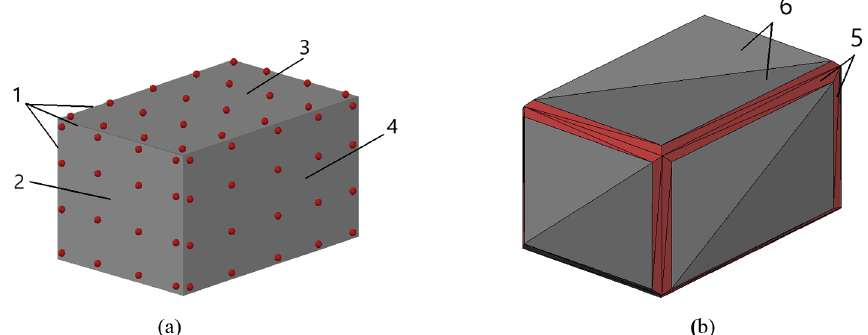
Fig. 1. An example of the metrological issue: (a) a cuboid object with CMM measured points; (b) an example of the convex polyhedron with the chamfer faces after convex-hull operation; 1 – edges; 2 – left side; 3 – top side; 4 – front side; 5 –“ chamfer ” polyhedron faces; 6 – ordinary